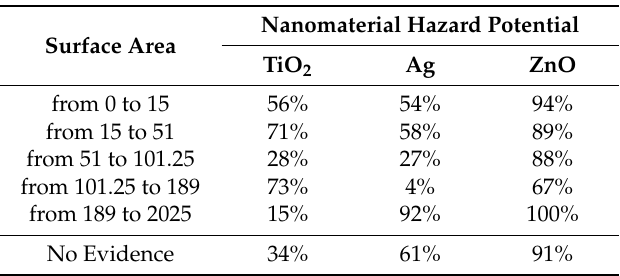
Table 5. Effect of surface area on the normalised NM hazard potential for TiO 2 , Ag, and ZnO.